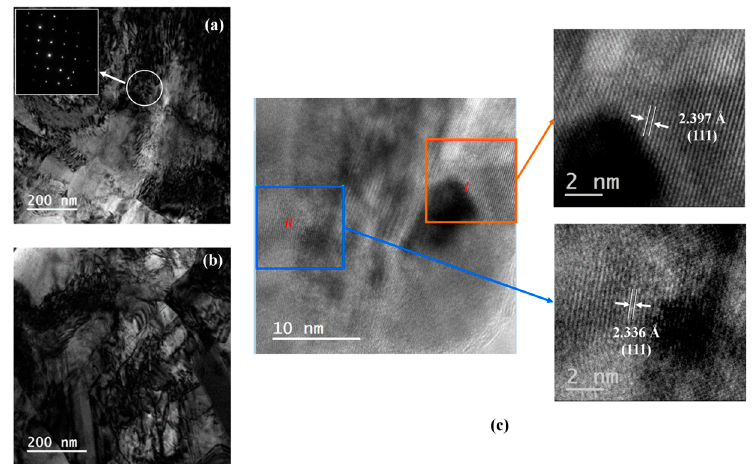
Figure 6. ( a ) The bright field TEM image from the plane view for Ag-Bi with selected area diffractions (SAD) patterns to illustrate a FCC structures ([001]) within highlighted area; ( b ) the TEM bright field image of Ag-Bi alloy with plenty of defects; and ( c ) the HRTEM images with areas in and out of the black Ag-Bi solid solutions.